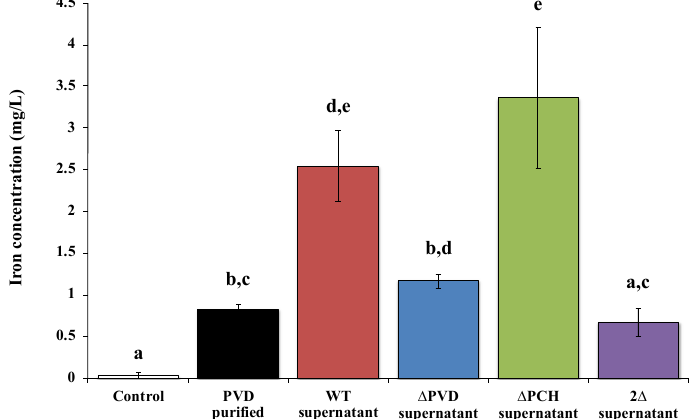
Figure 3. Concentration of iron dissolved from ground raw chrysotile (0.2 g) after 48 h incubation in the presence of succinate medium (control), 200 µ M Pseudomonas aeruginosa PAO1 purified pyoverdine (PVD purified) or culture supernatant of the wild type Pseudomonas aeruginosa PAO1 strain producing both siderophores pyoverdine and pyochelin (WT supernatant), a pyoverdine-deficient strain ( ∆ PVD supernatant), a pyochelin-deficient strain ( ∆ PCH supernatant), or a pyoverdine- and pyochelin-deficient strain (2 ∆ supernatant). Error bars indicate the standard errors of the means of three replicates. Bars with the same letter are not significantly di ff erent ( p > 0.05, Kruskal–Wallis test, three replicates). Adapted from David et al. [78].